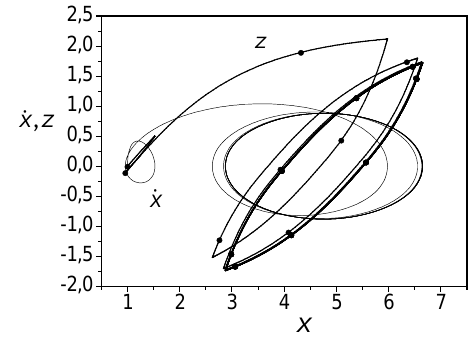
Fig. 1. System phase portrait and hysteresis change.